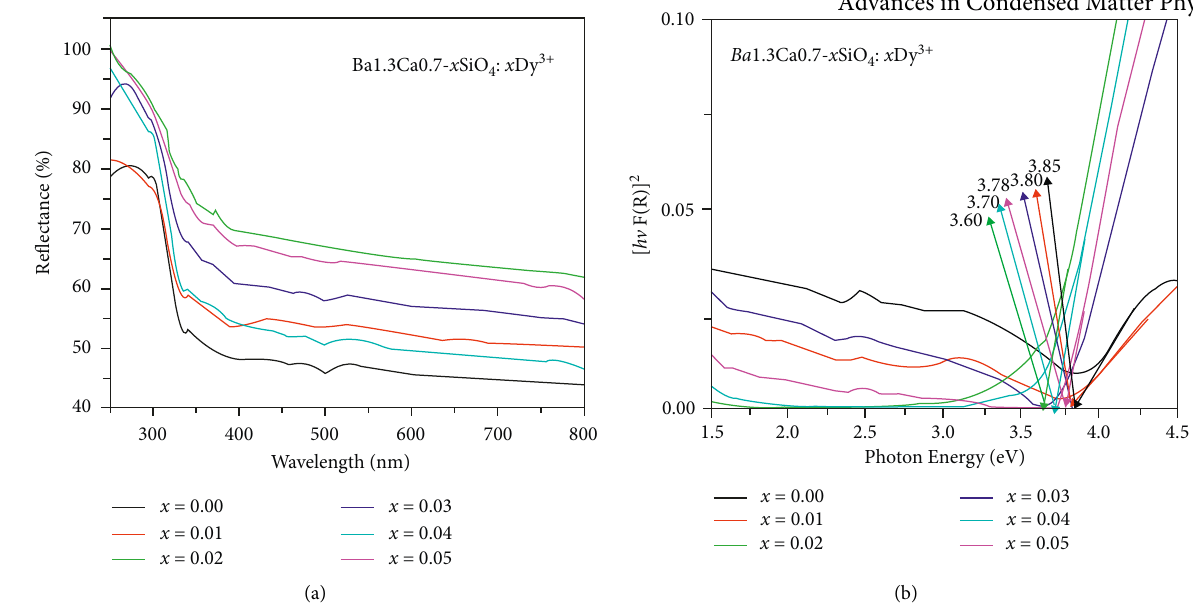
3+ ( x � 0.00, 0.01, 0.02, 0.03, 0.04, and 0.05). (b) Energy bandgap for 1.3 Ca 0.7 − x SiO 4 : x Dy